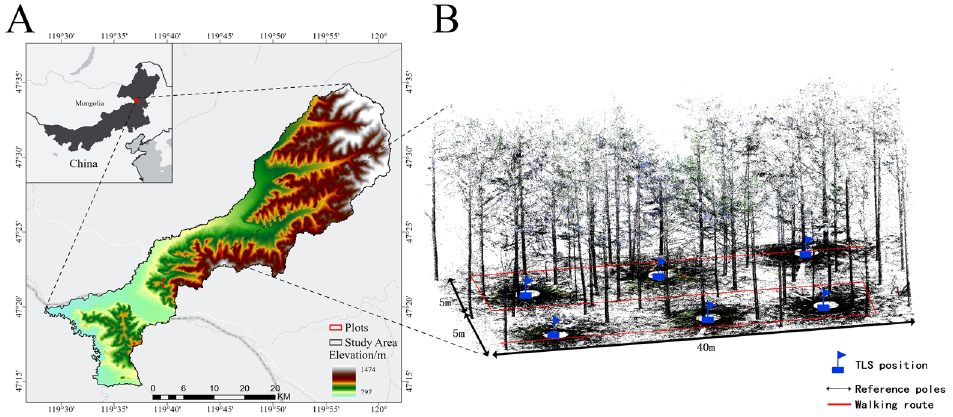
Figure 1. ( A ) Location of the study area, ( B ) the distribution of backpack LiDAR scanning tracks and TLS stations in the sample area.